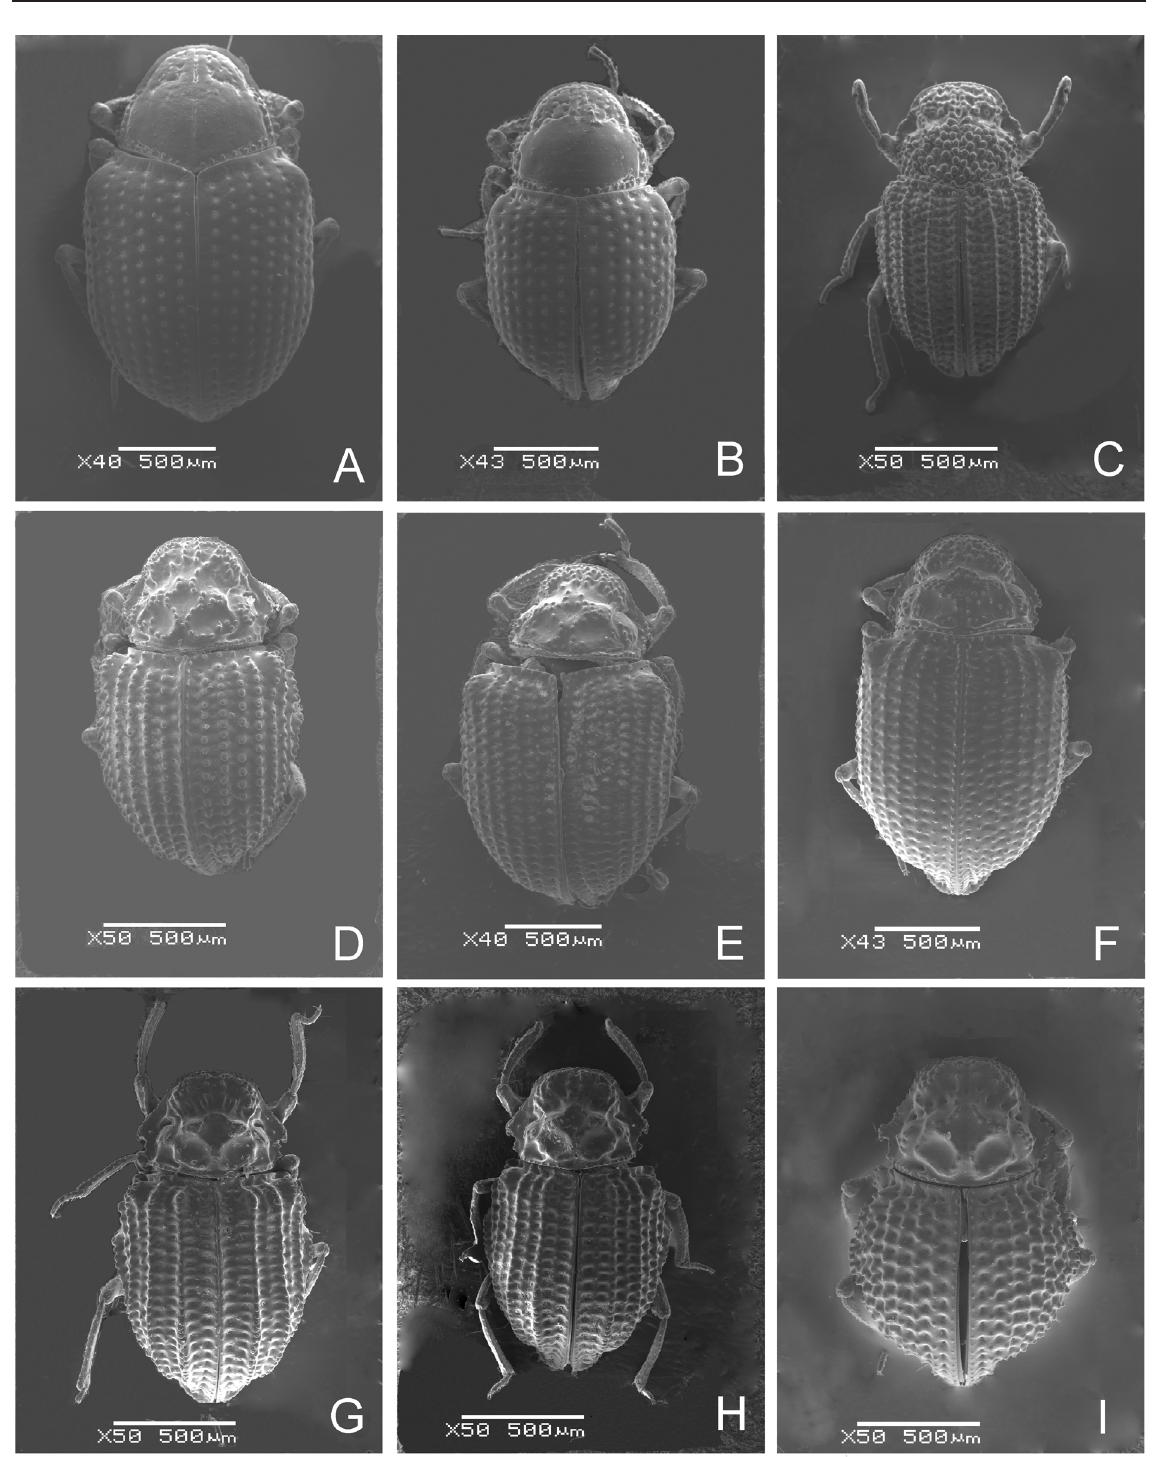
Fig. 5. Dorsal habitus of Georissus spp. A . G . ( G .) canalifer Sharp, 1888. B . G . ( G .) babai Satô, 1970. C . G . ( Ni .) granulosus Satô, 1972. D . G . ( Ne .) japonicus Satô, 1972. E–F . G . ( Ne .) kurosawai Nakane, 1963 from Hokkaido (E) and Nagano (F). G–H . G . ( Ne .) takahashii sp. nov. from Kochi (G) and Okinawa (H). I . G . ( Ne .) satoi sp.